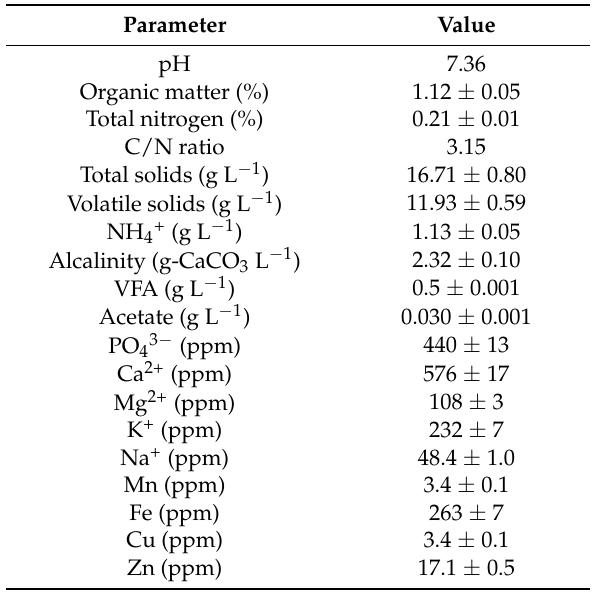
Table 1. Characterization of the anaerobic inoculum used in batch digestion experiments for evaluating digestion performance under overloading